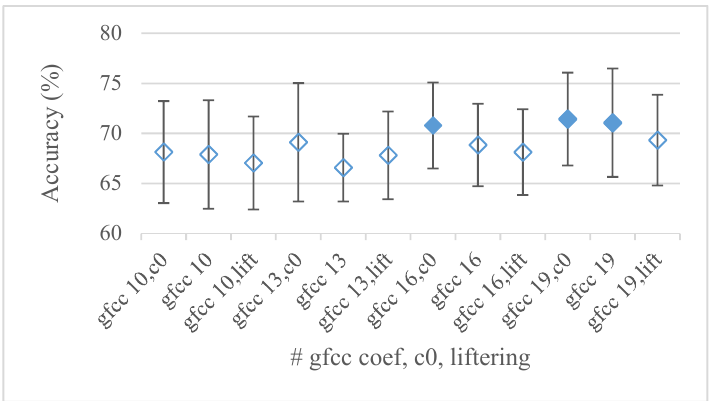
Figure 21. Averaged accuracies and standard deviations for the following GFCC settings: number of coefficients: 10, 13, 16, and 19, with and without c0, and liftering, for an 8 kHz maximal frequency and 60 FBs. Filled marks show equally performing settings.